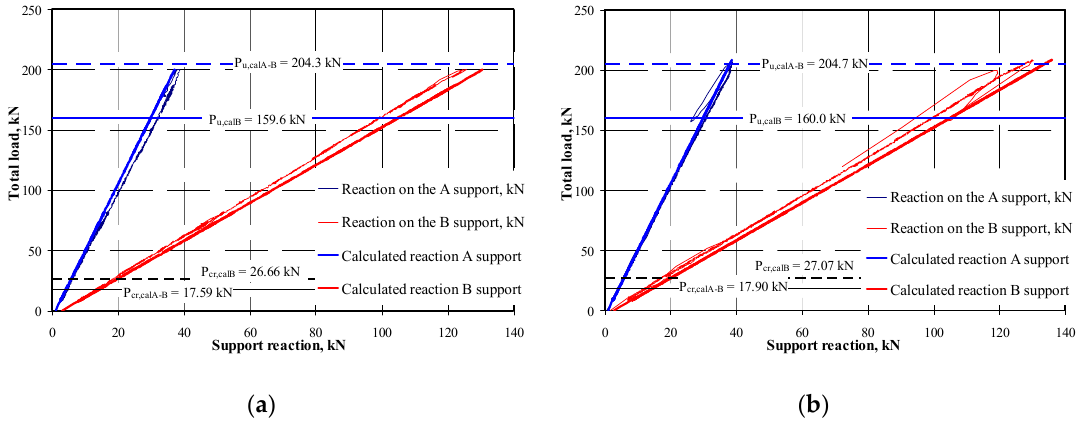
Figure 21. Changes in support responses: ( a ) Beam No. 1, ( b ) Beam No. 2.